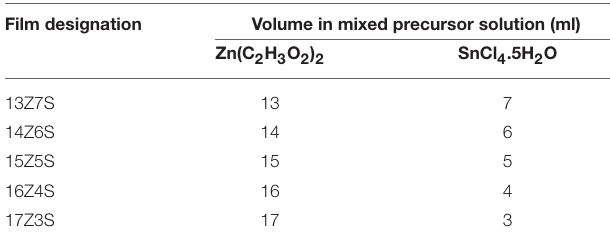
TABLE 1 | Volume of Zn and Sn ion in mixed precursor solution for different thin